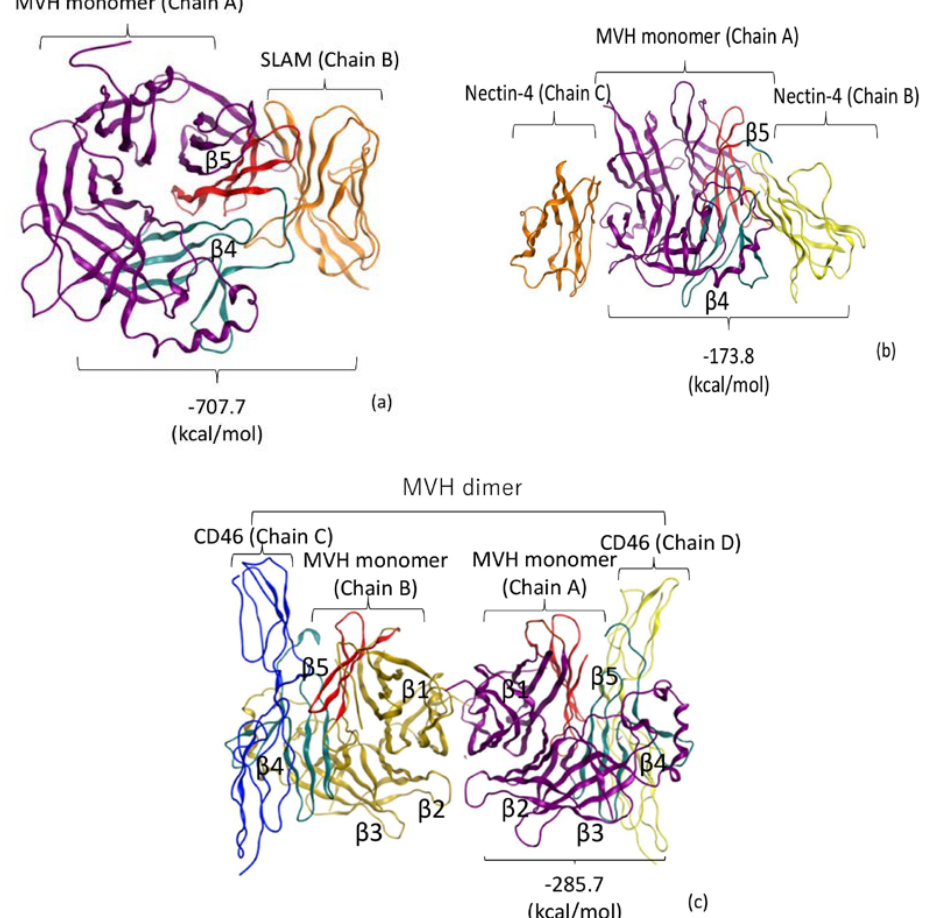
Figure 1. Crystal structures [11–13] of measles virus H protein (MVH)-receptor complexes employed for the fragment molecular orbital (FMO) calculations, where the β4 and β5 strand regions in MVH are depicted in cyan and red colors, respectively, along with the calculated values of inter-fragment interaction energies (IFIE) sums for the MVH-receptor interactions. ( a ) Complex of signaling lymphocyte-activation molecule (SLAM) and MVH, where Chain B (SLAM) is complexed with Chain A (MVH). ( b ) Complex of Nectin-4 and MVH. Two receptor chains, Chain B and Chain C, are complexed with MVH (Chain A) at different interfaces. The binding of Chain C is regarded as an artifact because of crystal packing [13]. ( c ) Dimeric complex of CD46 and MVH. Chain C and Chain D of the CD46 receptor are complexed with Chain B and Chain A of MVH, respectively, where the β1 – β5 regions in MVH are designated.